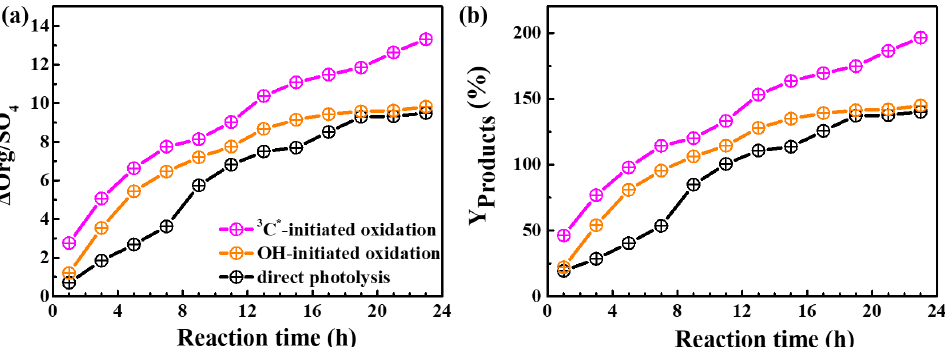
− ) and (b) mass yields of reaction products with reaction time 4